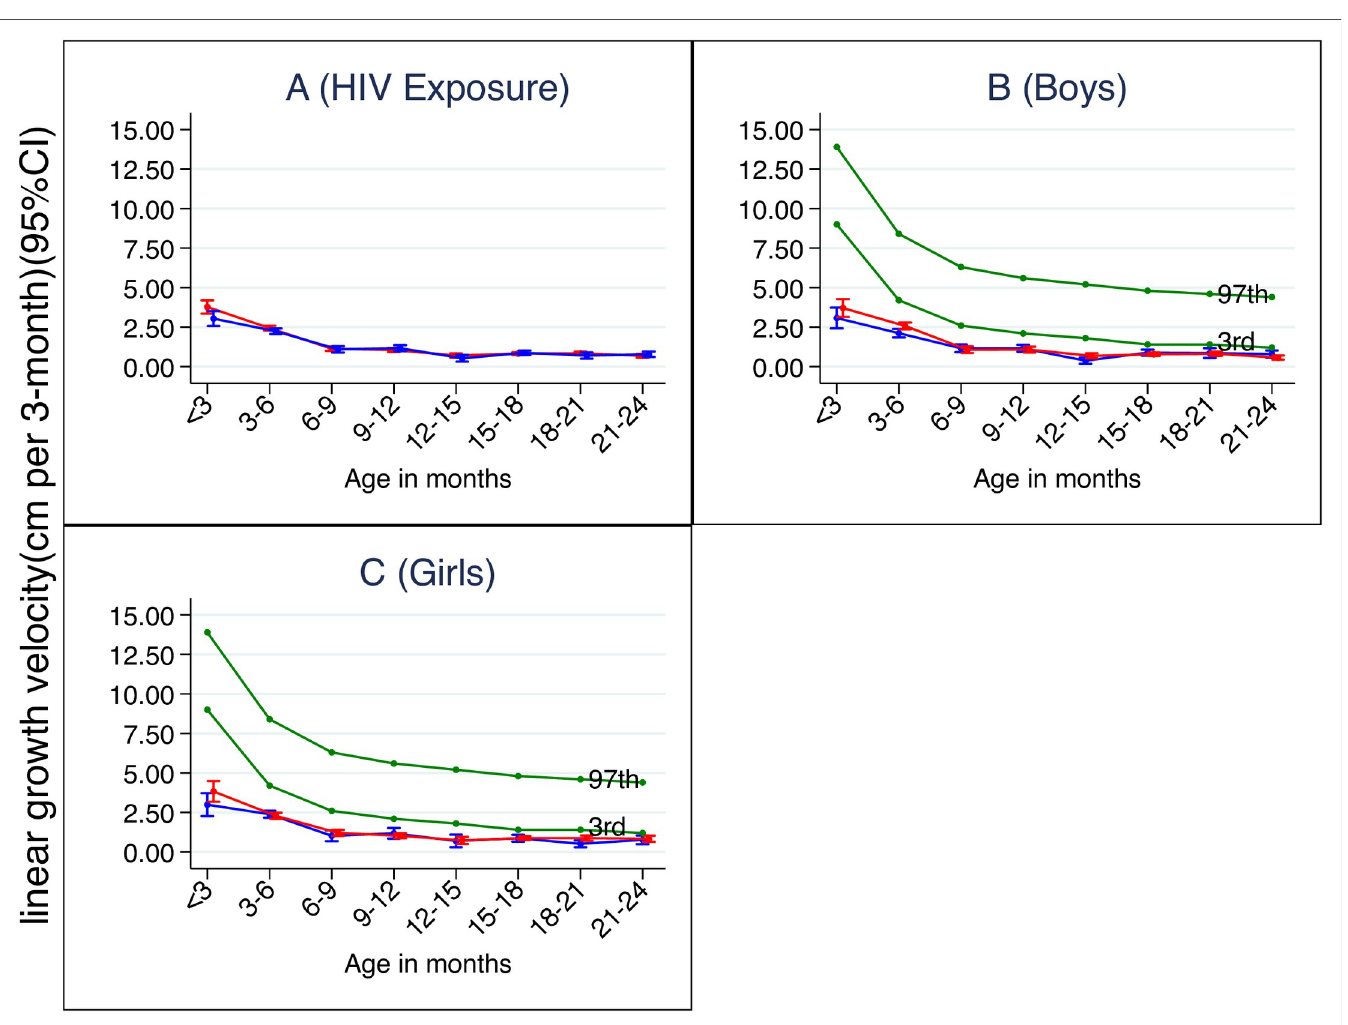
Fig 1. Three-monthly empirical linear growth velocity. In green are the WHO linear growth velocity standard (3rd and 97th percentiles), In blue is the three-monthly empirical growth of infants who are HIV unexposed and uninfected, while in red is the empirical growth of infants who are HIV exposed and uninfected with a 95% Confidence interval (CI). Overall growth velocity average per 3months’ time by HIV exposure (a); Average growth velocity per 3 months for the boys (b); Average growth exposure for girls